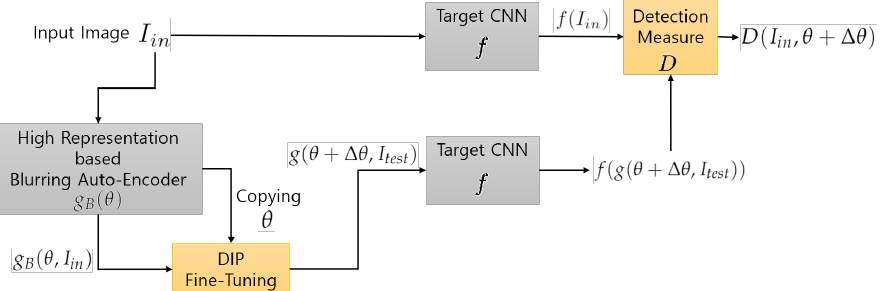
Figure 4. Diagram of the proposed AI deception attack detection